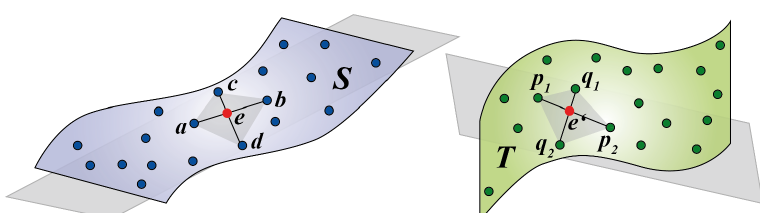
Figure 2. Affine invariant ratio for congruent 4-points. Given points from a surface S , let points a , b , c , d be coplanar, and the lines ab and cd meet at point e . The ratios r 1 = || a − e || / || a − b || and r 2 = || c − e || / || c − d || are preserved under any affine transform. If T is another surface which (partially) matches S and the 4-points coplanar base lies in the overlap region, then the set of corresponding points from T are coplanar, and satisfy the following relations: || p 1 − e (cid:48) || / || P 1 − P 2 || = r 1 and || q 1 − e (cid:48) || / || q 1 − q 2 || = r 2